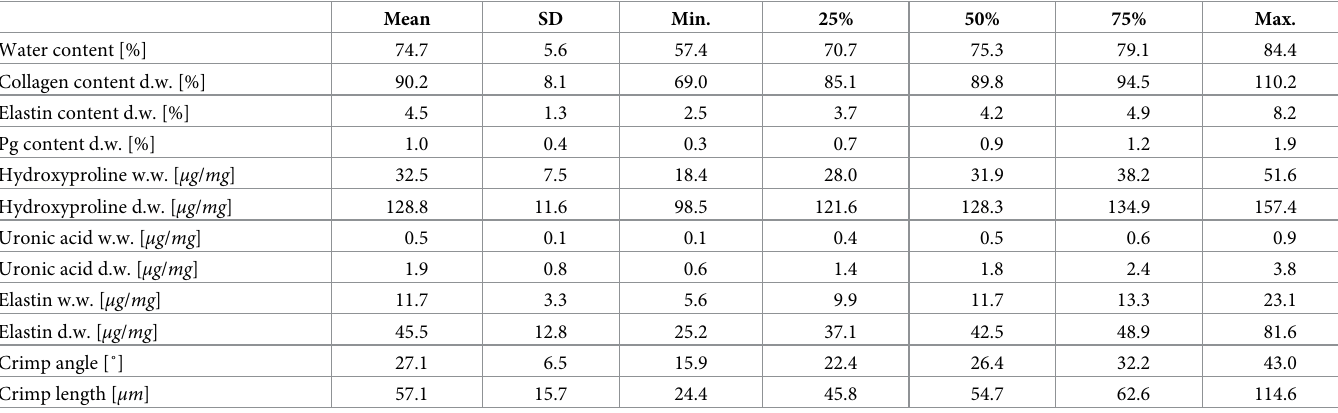
Table 1. Distributions of the biochemical and structural reference variables. Mean